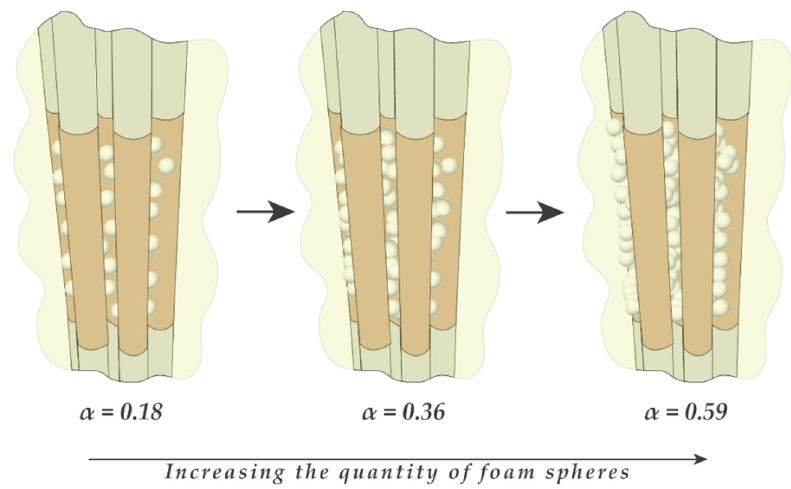
Figure 30. Schematic sketch of the foam spheres experiment.